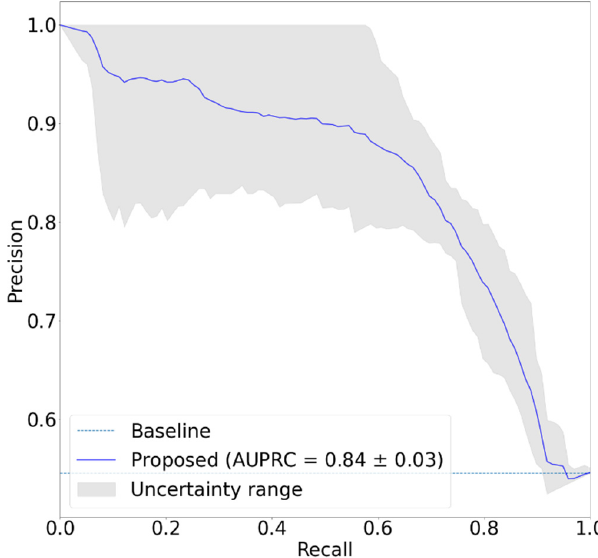
Figure 7. Precision-recall curve of proposed model. Grey area represents the range of uncertainty. AUPRC: Area under curve of precision-recall curve.